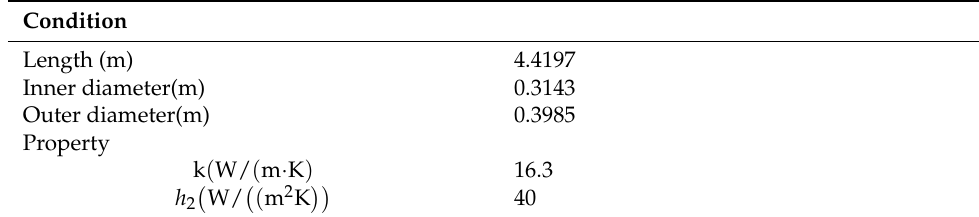
Table 1. The specifications of the hydrogenated storage tank and simulation